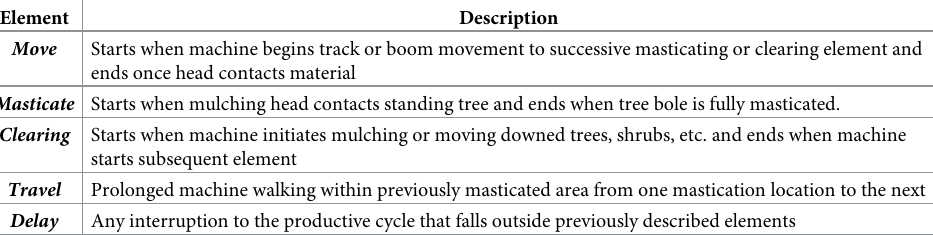
Table 1. Cycle elements used for the mastication time and motion